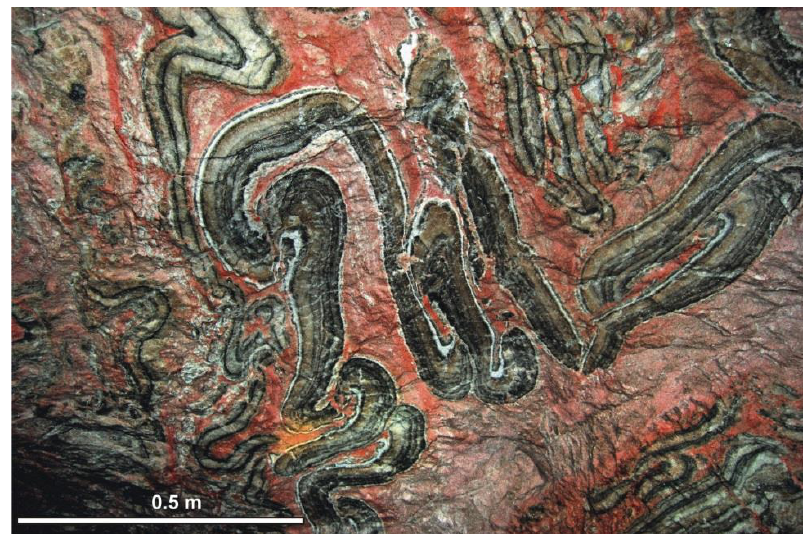
Figure 9. Folded beds of rock salt (dark) and carnallite-kieserite (red and pink). The Younger Potash (K3) unit, Z-3/2 profile in the gallery of salt mine KŁODAWA S.A., mine level 600 m, Kłodawa salt dome.